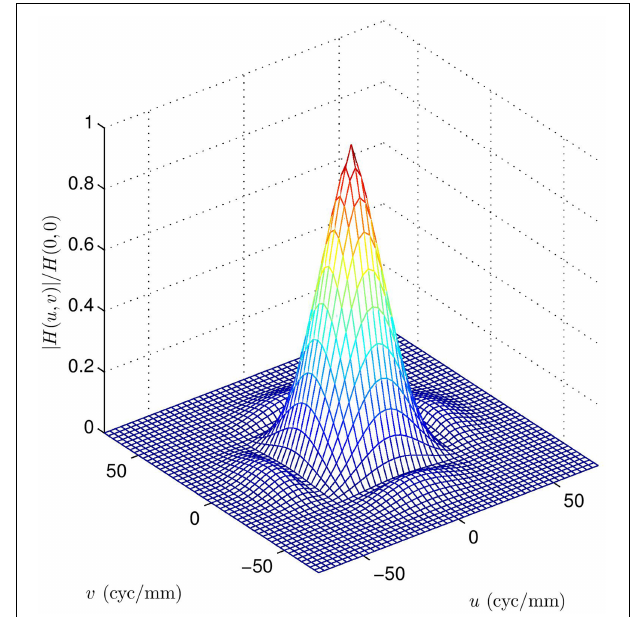
FIGURE 10 | Overall system MTF for the diffraction OTF in Figure 3 ( F = 3 . 33 , λ = 4 . 5 μ m), and the detector MTF in Figure 7 (square with